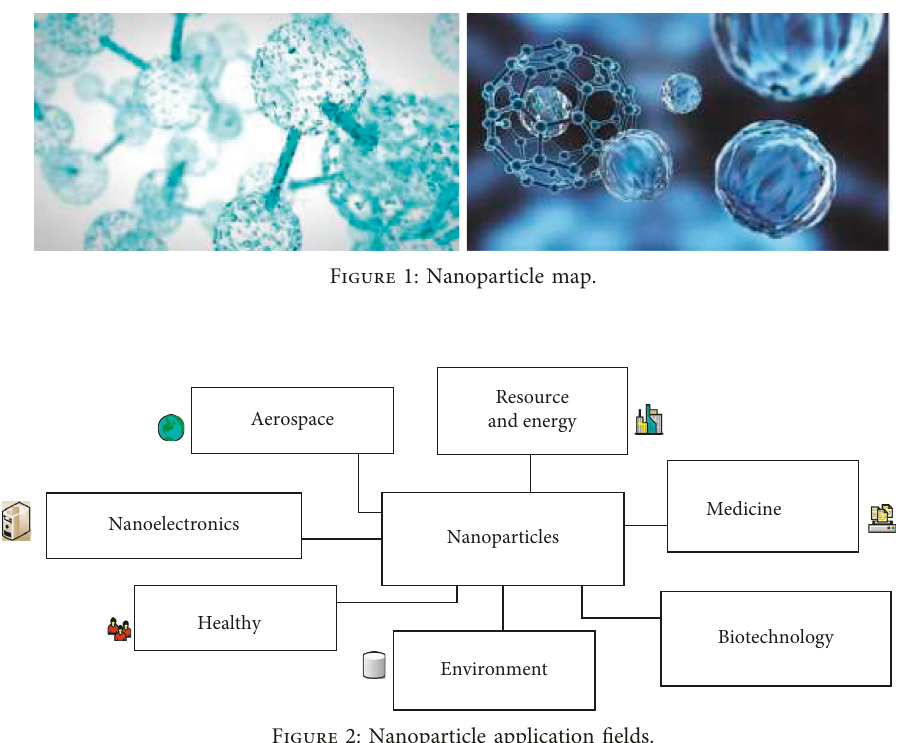
Figure 2: Nanoparticle application